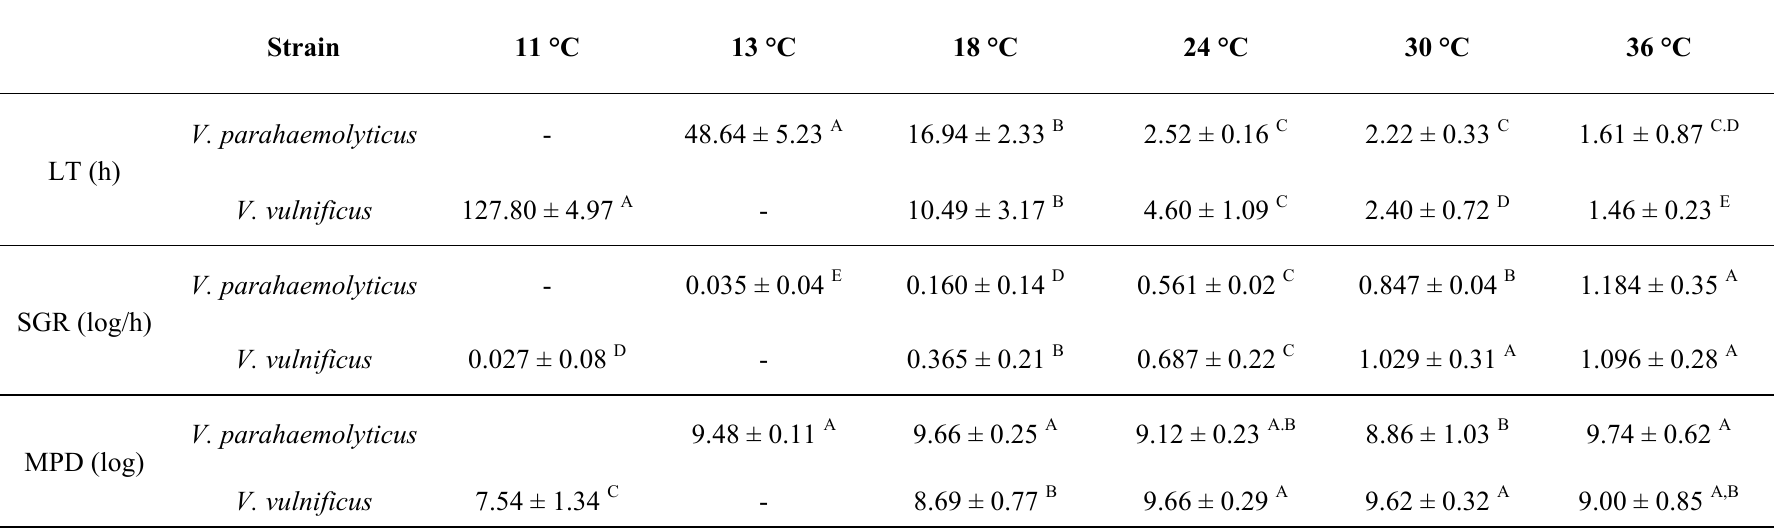
Table 1. Effect of temperature on Lag time (LT) and specific growth rate (SGR), and maximum population density (MPD) of V. parahaemolyticus and V. vulnificus in